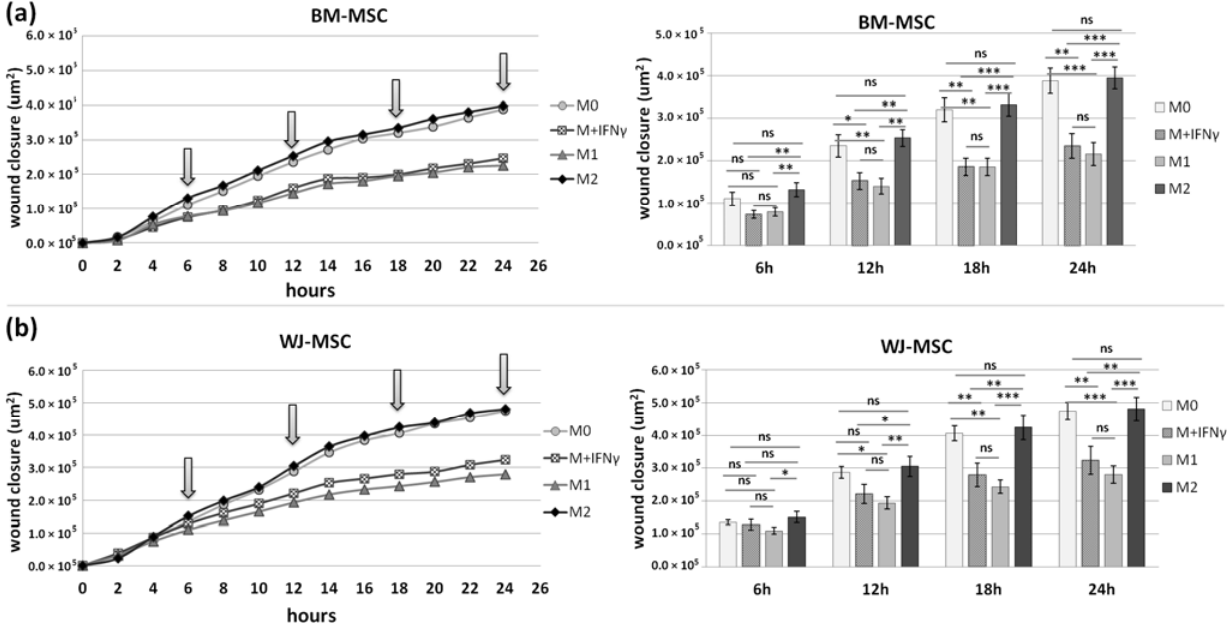
Figure 10. The effect of different subsets of macrophages on the mobility of human BM-MSCs ( a ) and WJ-MSCs ( b ). The scratch assay. The “wound” closure was documented every 2 h for 24 h, and statistical analysis was performed at 6, 12, 18, and 24 h time points. Scratch covering presented in μ m 2 in time (h) in relation to the time point 0. MSCs migrated in the presence of conditioned medium from M0 macrophages (M0), IFN γ -stimulated macrophages (M IFN γ ), IFN γ /LPS- stimulated macrophages (M1), and IL-4/IL-10-stimulated macrophages (M2). Bars represent mean values ( ± SEM). Data were analyzed using one-way ANOVA with Tukey post-hoc correction. * p < 0.05; ** p < 0.01; *** p < 0.001; ns—statistically not significant. Data collected during 3 independent experiments, MSCs from 4 different donors used for each MSC type, macrophages from 5 different donors used, n =